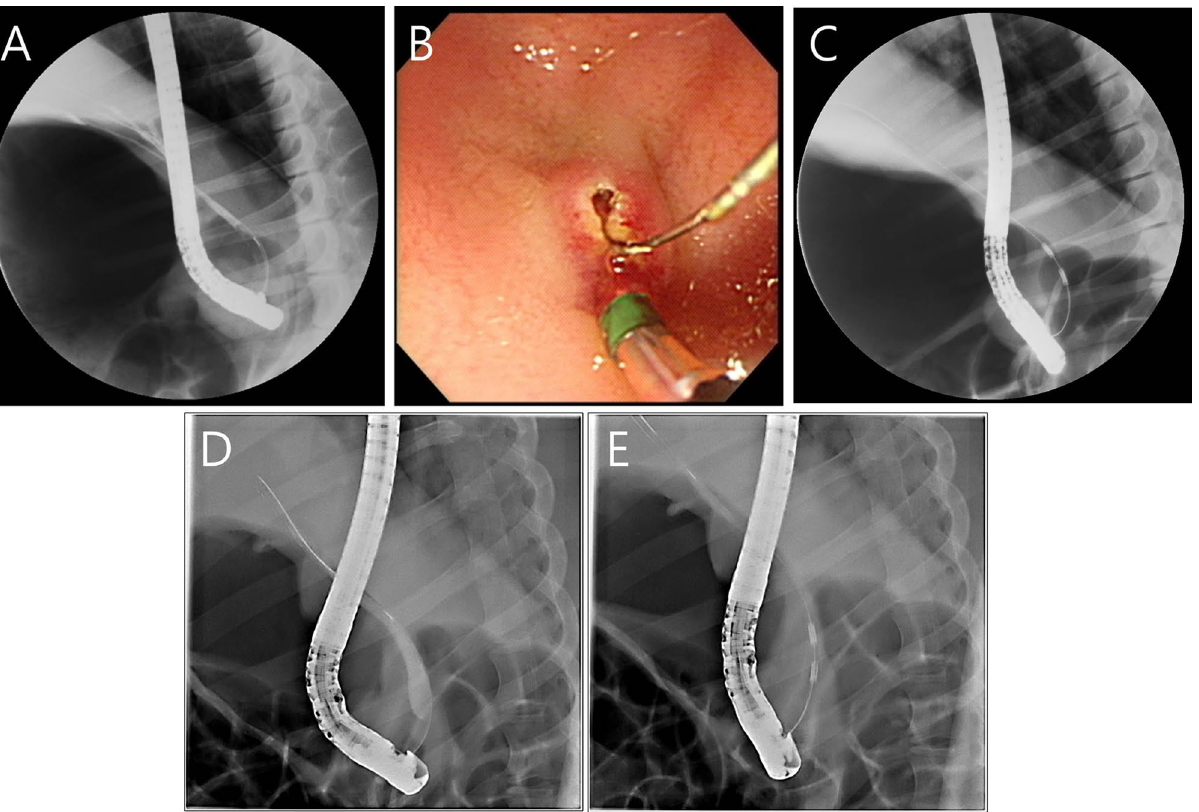
Figure 2. Endoscopic retrograde cholangiography examination of a miniature pig during endobiliary RFA. ( A ) Cholangiogram shows non-dilated CBD before endobiliary RFA. ( B ) Endoscopic biliary sphincterotomy. ( C ) Fluoroscopic examination shows the RFA catheter positioned in the distal CBD while performing RFA. ( D ) and ( E ) Fluoroscopic views show the suction technique as in vacuum evacuation to maximize the contact between the CBD mucosa and the RFA catheter, even if the CBD was